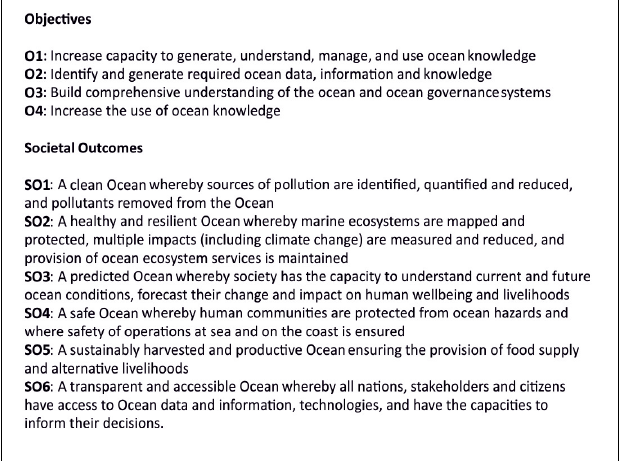
FIGURE 1 | Decade of Ocean Science for Sustainable Development objectives identified in the recently published revised Draft Implementation Plan, and societal outcomes published in the revised Decade Roadmap.